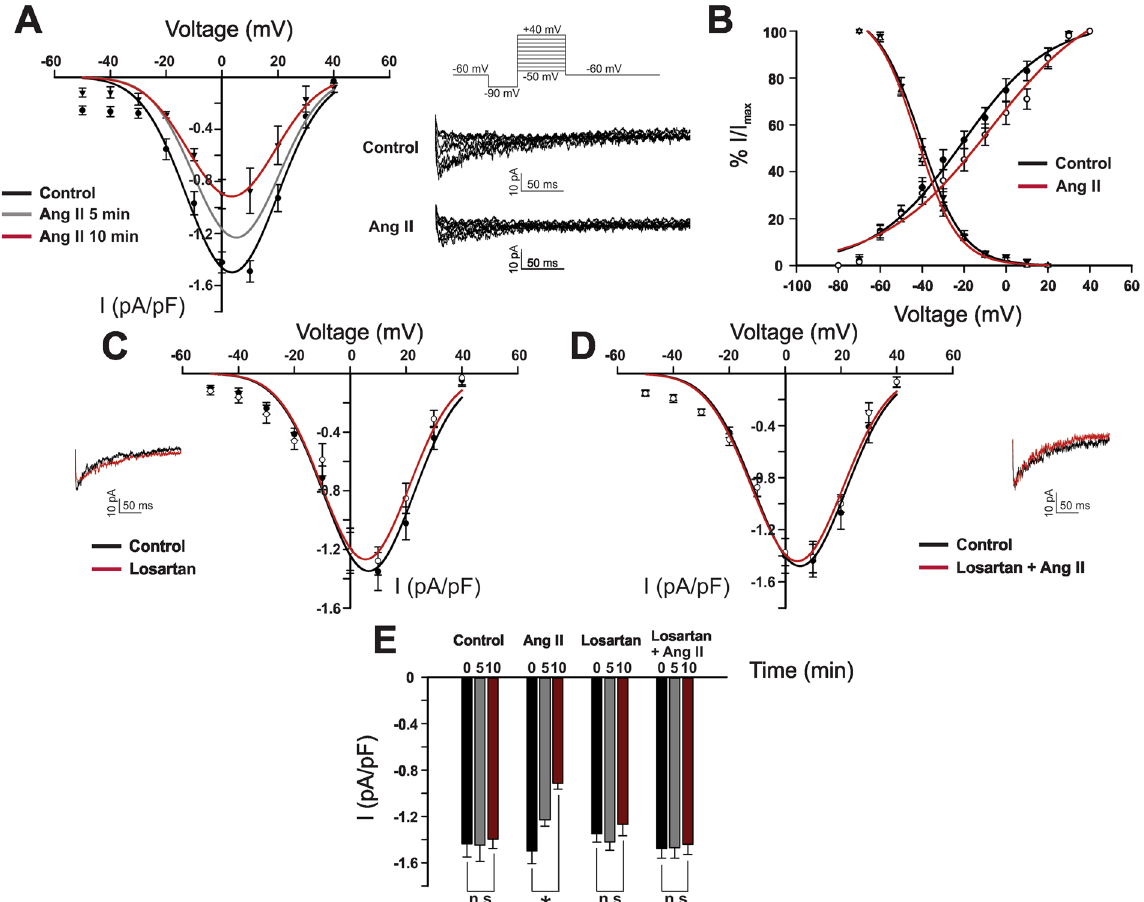
Figure 1. Angiotensin II inhibits T-type Ca 2 + channels via the AT 1 receptor in cerebral arterial smooth muscle cells. ( A and B ) Representative traces, averaged I-V plots, and voltage dependence of activation and steady state inactivation of whole cell T-type current prior to and following Ang II application (100 nM) (n = 8). ( C and D ) Representative trace and average I-V plot of the T-type current in cells treated with losartan (1 µ M) and then Ang II (n = 8). ( E ) Peak T-type current (pA/pF) at 5 min intervals under control condition and following treatment with losartan ± Ang II (n = 8). All recordings were performed in the presence of 200 nM nifedipine and using Ba 2 + as a charge carrier. * Denotes significant difference compared to control ( * P < 0.05, paired t